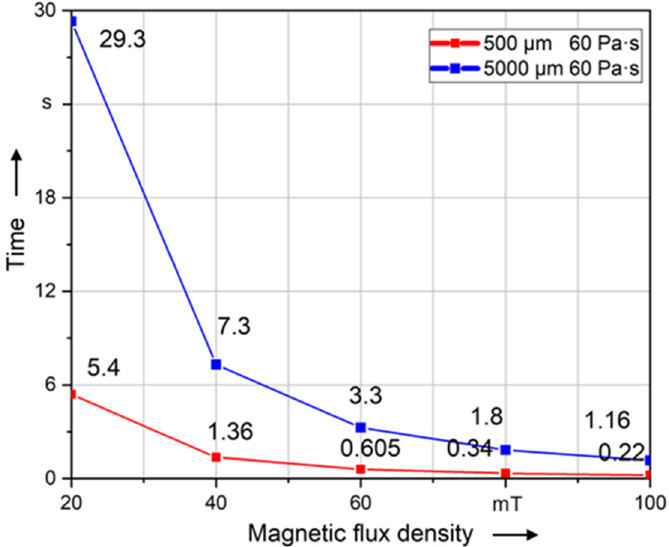
Figure 13. Time required to align short (500 µm) and long fibers (5000 µm) of different magnetic flux densities to 99% of 90° at a constant viscosity.